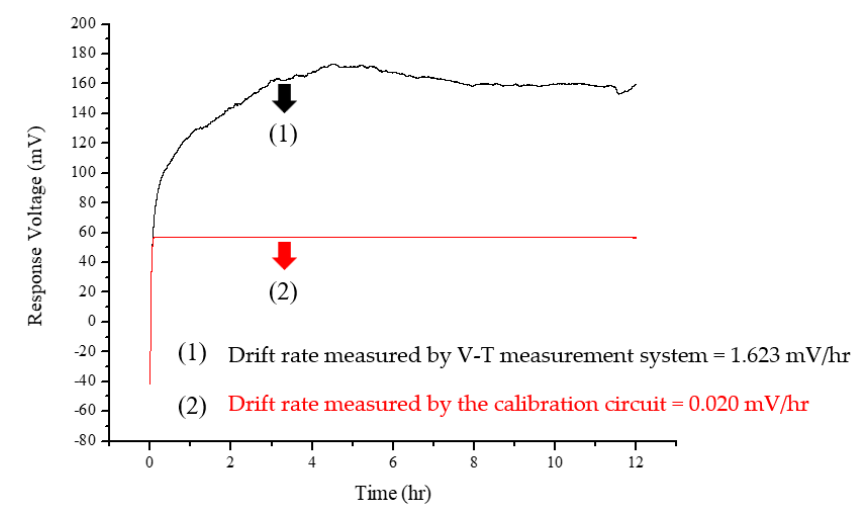
Figure 9. The drift effect experiment results in the flexible arrayed RuO 2 urea biosensor. Table 3. Comparison of drift rates of urea biosensor with different sensing membranes.